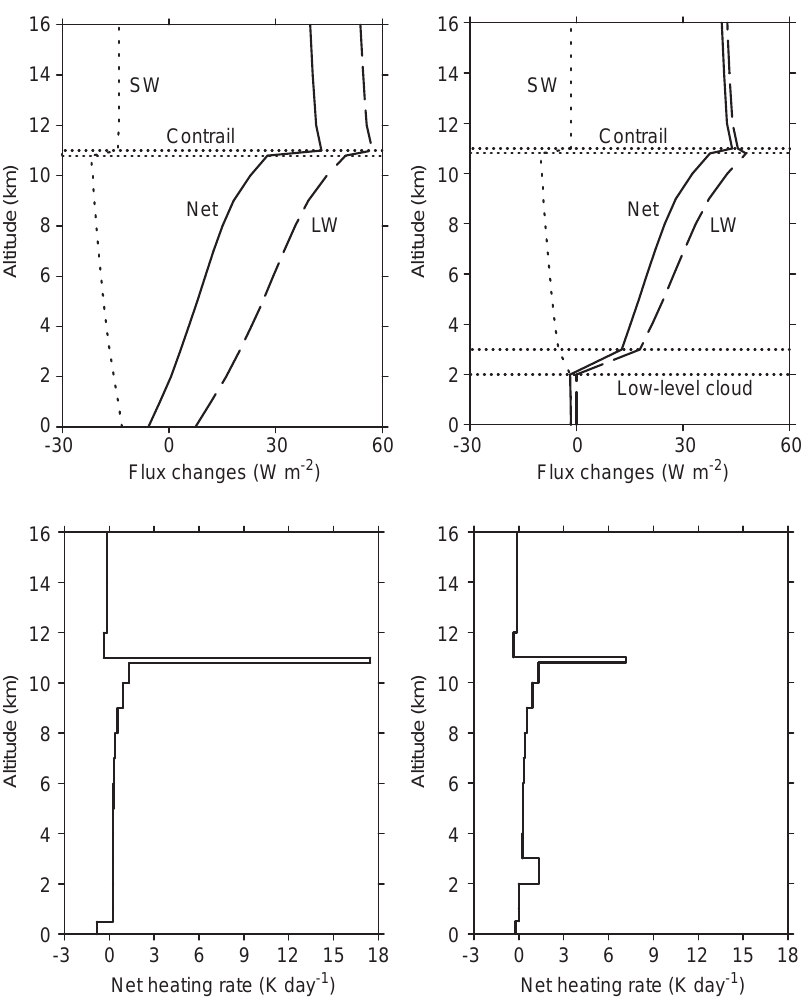
Fig. 5. Vertical profiles of shortwave ( SW ), longwave ( LW ) and net flux changes ( top ) and net heating rate ( bottom ) induced by a contrail (at altitude as indicated by horizontal dotted lines ) for the reference case ( left , optical depth 0.52; case a) and the same case but with a low- level water cloud at 2–3 km altitude ( right ). The net heating rate is plotted as mean values over certain altitude intervals as indicated by the step functions. The flux profile is the linear interpolation between the flux values at the boundaries of these altitude intervals. The heating rate near the surface illustrates the net change in the radiative heat budget at the surface assuming adiabatic surfaces and a uniform mixing of heat across the lowest 500 m of